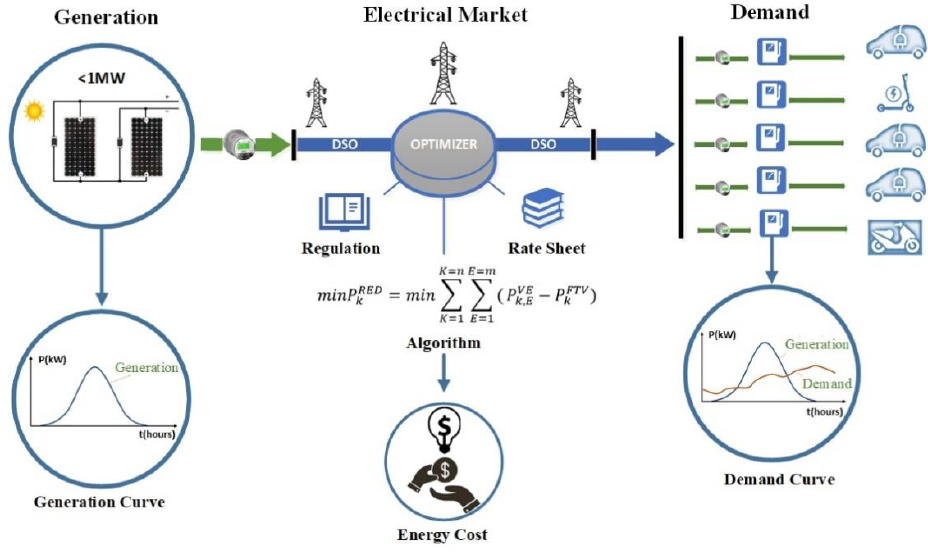
Figure 13. Methodology for demand management in recharging EVs.